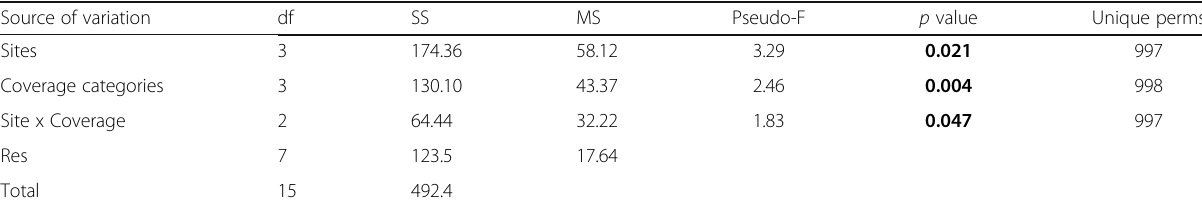
Table 2 Details of the two-way PERMANOVA test conducted on ln(x + 1)-transformed phytobenthos community abundance data recorded at the sampling sites Source of variation df SS